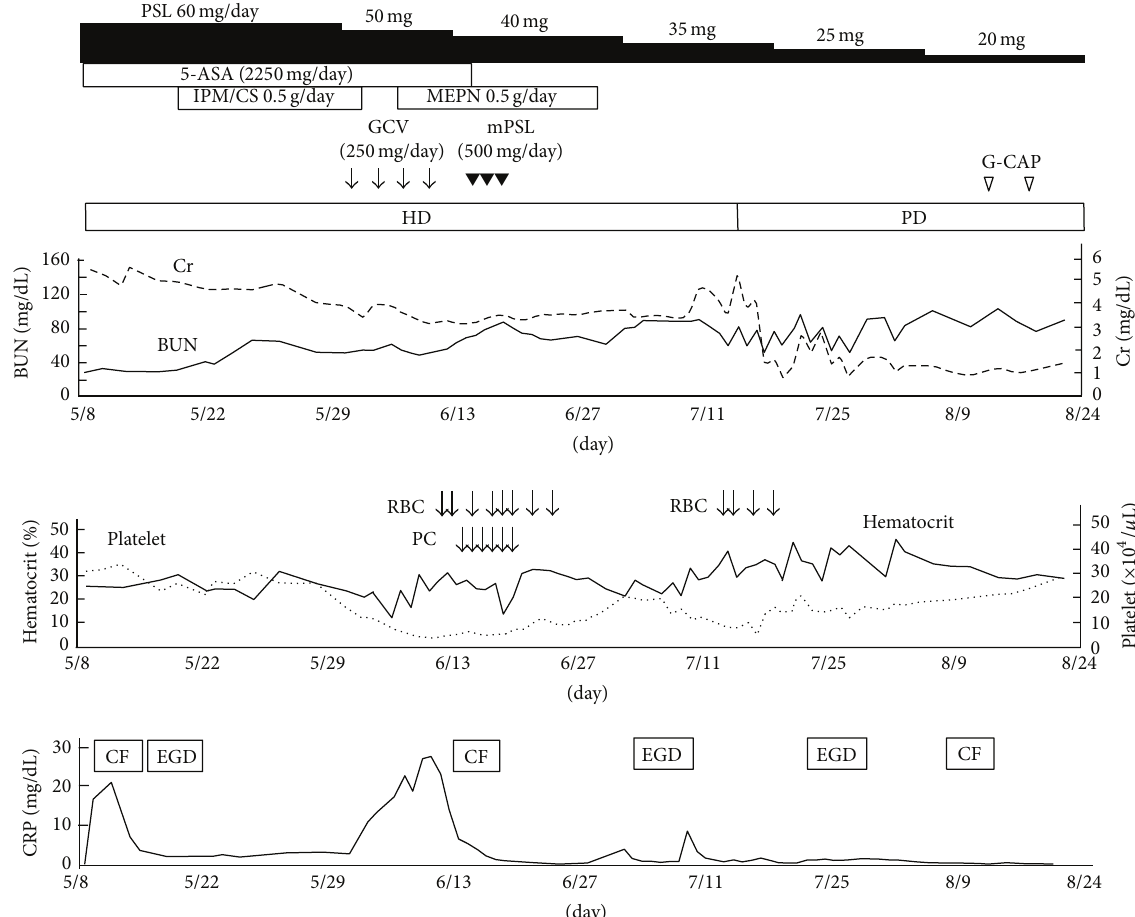
Figure 3: Clinical course. 5-ASA, 5-aminosalicylic acid; CF, colon fiber; BUN, blood urea nitrogen; Cr, creatinine; CRP, C-reactive protein; G-CAP, granulocyte and monocyte adsorption apheresis; GCV, ganciclovir; EGD, esophagogastroduodenoscopy; HD, hemodialysis; IPM/CS, imipenem/cilastatin; MEPN, meropenem; mPSL, methylprednisolone; PC, platelet concentrate; PD, peritoneal dialysis; PSL, prednisolone; RBC; red blood